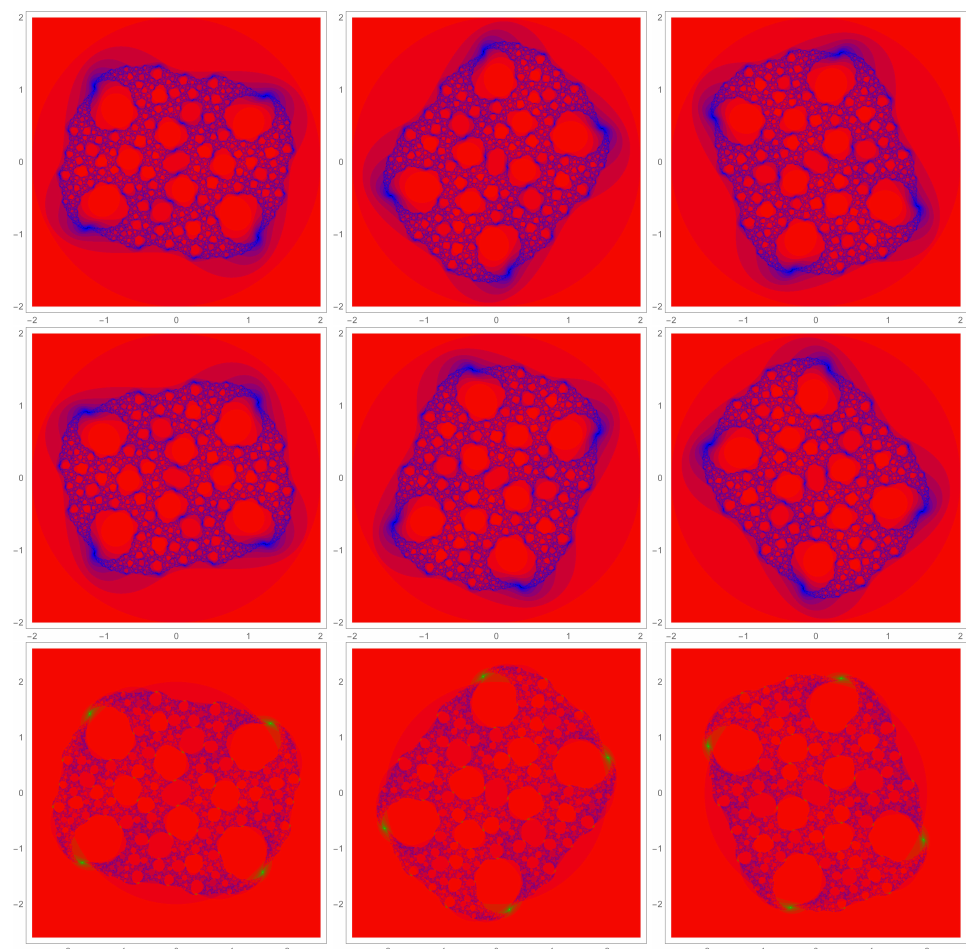
Figure 5. Nature of the three-fold symmetry of the j -averaged Mandelbrot set on the j -averaged filled- in Julia sets. The top left panel shows the j -averaged filled-in Julia corresponding to λ = − 0.45 + 0.05 i . The top middle and right panels show λ = ( − 0.45 + 0.05 i ) e 2 π i 3 and λ = ( − 0.45 + 0.05 i ) e − 2 π i 3 , respectively. The second row shows the j -averaged filled-in Julia sets corresponding to reflecting λ across the respective dihedral mirrors. The bottom row shows the j -averaged filled-in Julia set coming from the simple inversion case ( A ≡ I ( 0,1,1,0 ) ). Each respective value of λ is 1.889090 times that from the top row. The j -averaged filled-in Julia sets look similar but not identical, and they are about 1.35 times